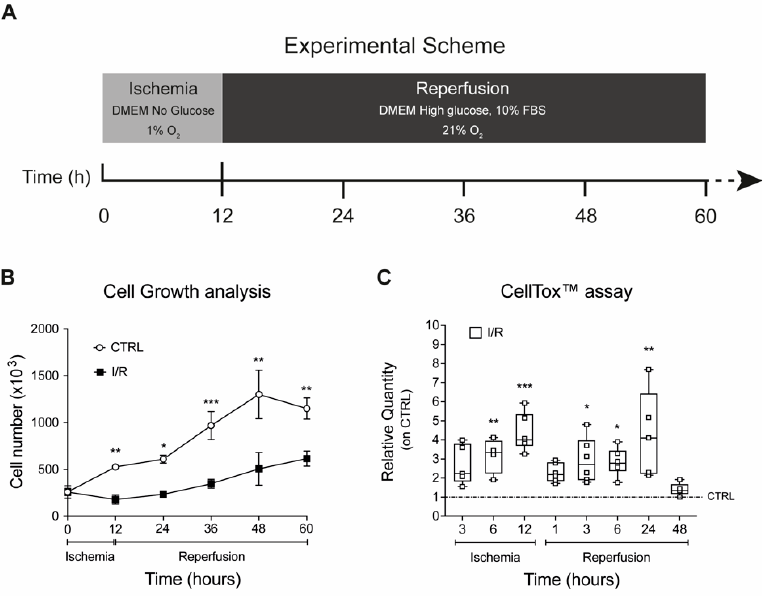
Figure 2. Effects on cell proliferation and cytotoxicity in an in vitro model of IRI. ( A ) Schematic representation of in vitro model of IRI; effects of IRI on H9c2 in terms of proliferation ( B ) and cytotoxicity ( C ). Each square in the graphs represent an experimental replicate. In the legend: CTRL represents H9c2 cells maintained in normoxic culture conditions; I/R represents H9c2 cells exposed to ischemia and reperfusion. Statistical significance was determined by the nonparametric Kruskal-Wallis test. * p < 0.05; ** p < 0.01; *** p < 0.001.